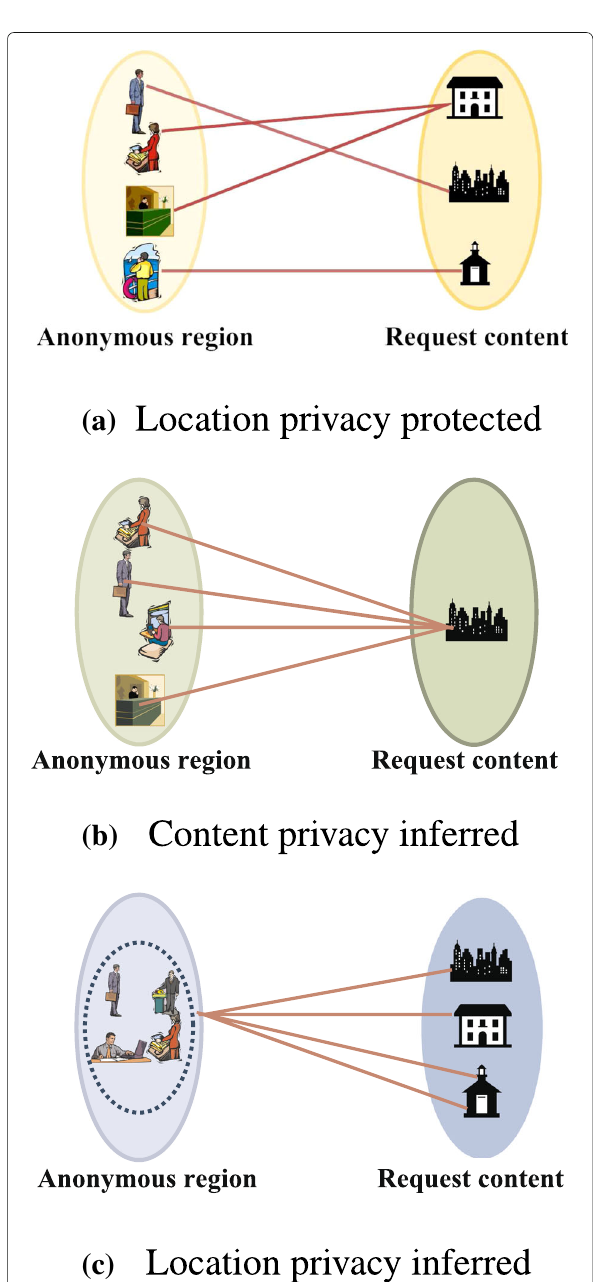
Fig. 3 LBS request type It shows three real scenarios that users send requests to the LBS server. In each subgraph, the left part represents the user’s anonymous region and the right part shows the diversity of content requested by the user. The lines connecting the two parts represent the relationship between the user request and the corresponding LBS service. a Location privacy protected. b